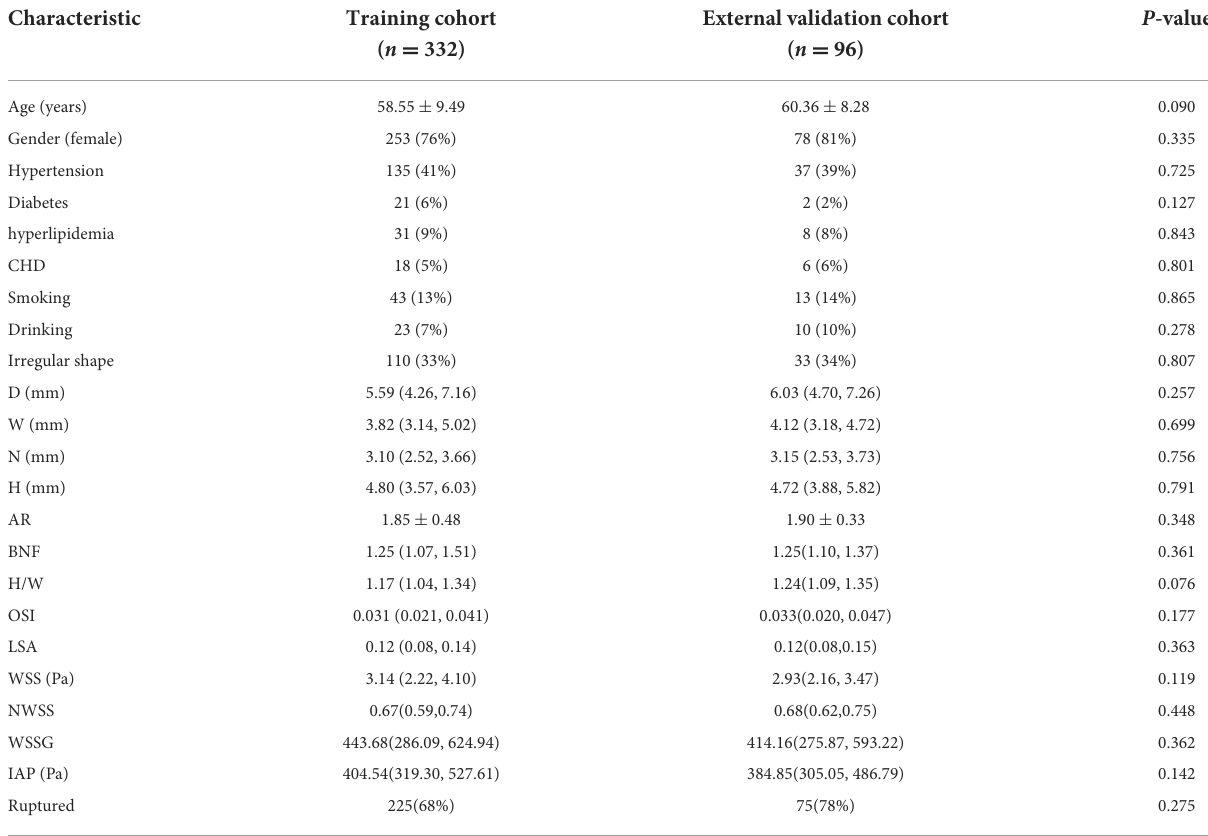
TABLE 1 Clinical, morphological, and hemodynamic characteristics in training cohort and external validation cohort. Characteristic Training cohort External validation ( n = 332)